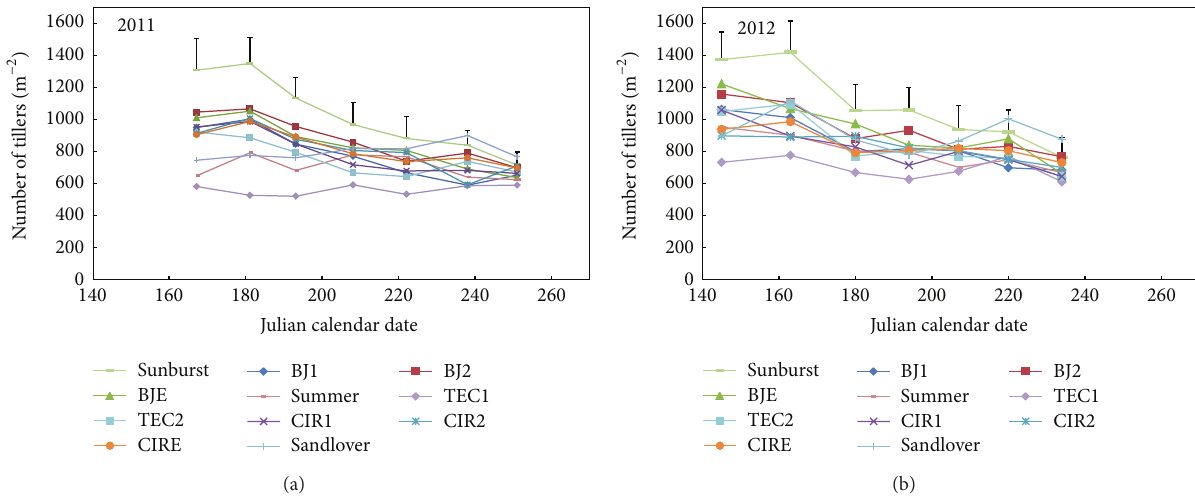
Figure 1: Number of tillers m −2 of 11 selections of switchgrass at Sainte-Anne-de-Bellevue, Quebec, in 2011 and 2012. Vertical bars represent the least significant difference (LSD, 𝑃 = 0.05 ) at each sampling point throughout the season. BJ1, Blue Jacket; BJ2, Blue Jacket II; BJE, Blue Jacket Early; TEC1, Tecumseh; TEC2, Tecumseh II; CIR, Cave-in-Rock; CIR2, Cave-in-Rock II; CIRE, Cave-in-Rock